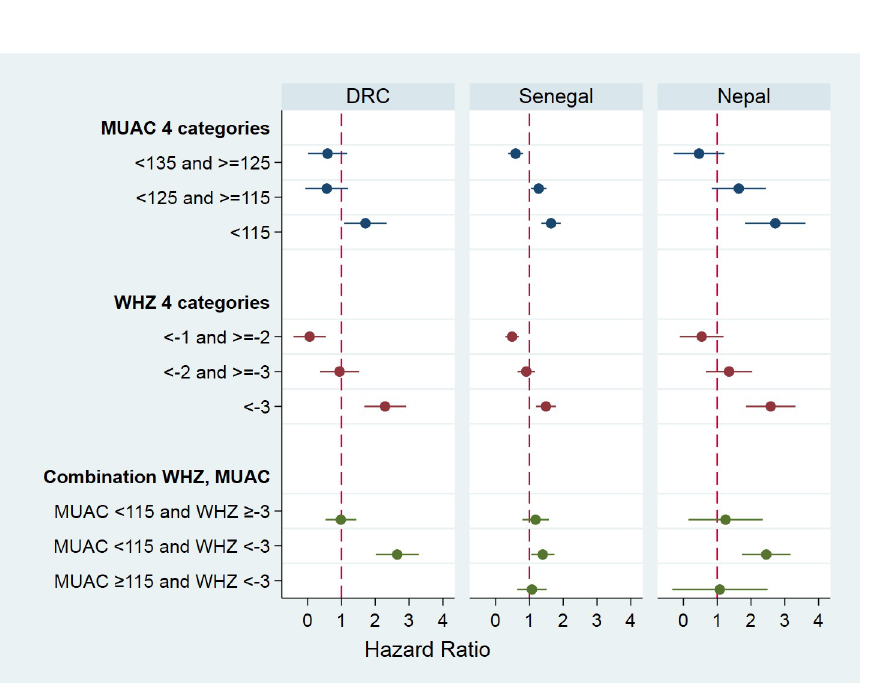
Fig 3. Hazard ratios with 95% CI resulting from Cox proportional hazard regression models separately for each of the three original studies. The reference categories are � 135 mm for MUAC; � -1 Z-scores for WHZ; and MUAC � 115 and WHZ � -3 for the combination of